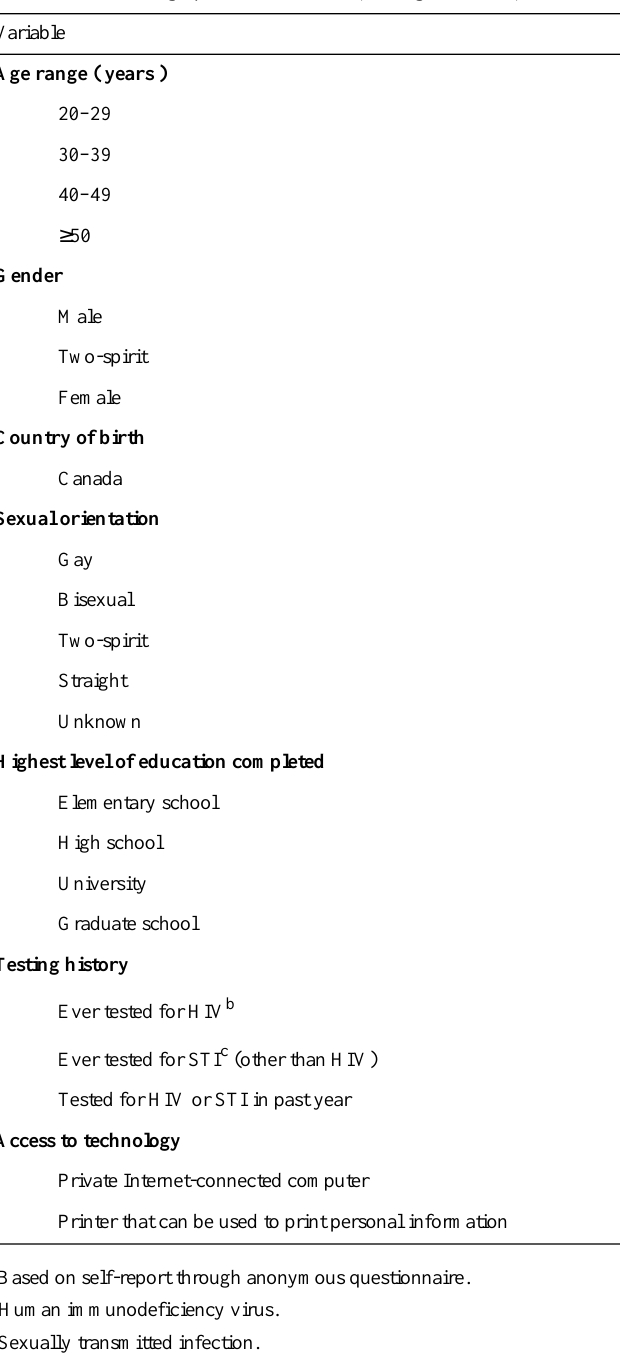
Table 1. Sociodemographic characteristics, testing behaviors, and access to relevant technology among focus group participants (N = 39). a